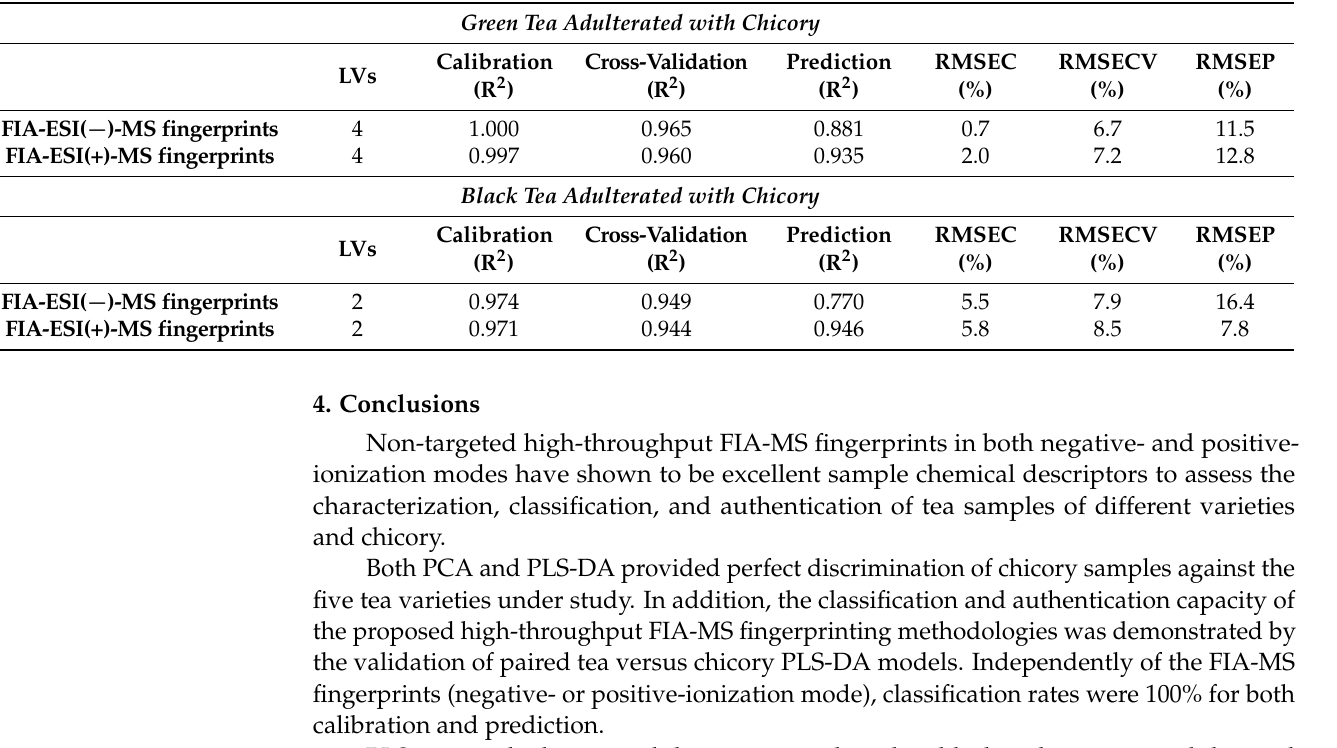
Table 4. PLS regression results for the two adulteration cases under